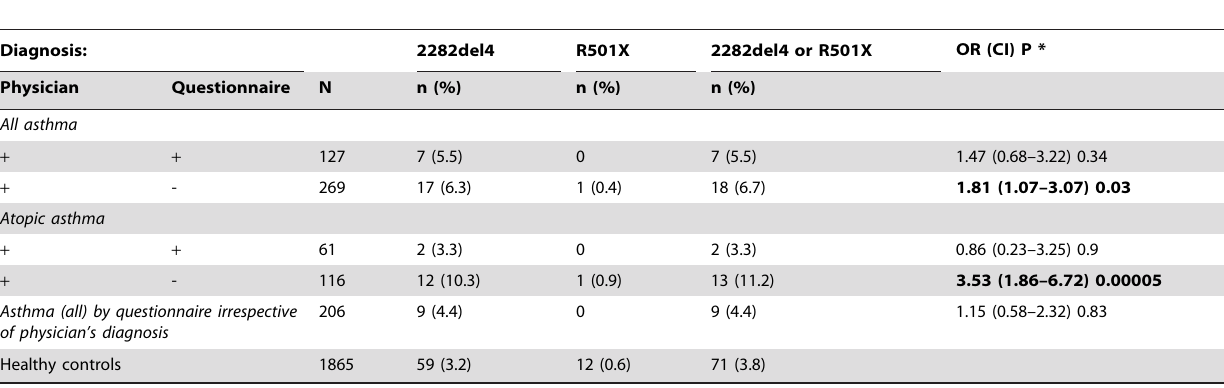
Table 2. Prevalence of the FLG variants vs. concordance between diagnosis of asthma (all kinds or atopic asthma) by a physician (i.e. diagnosed during the present study) and individual awareness of having asthma (all kinds) according to questionnaire data.